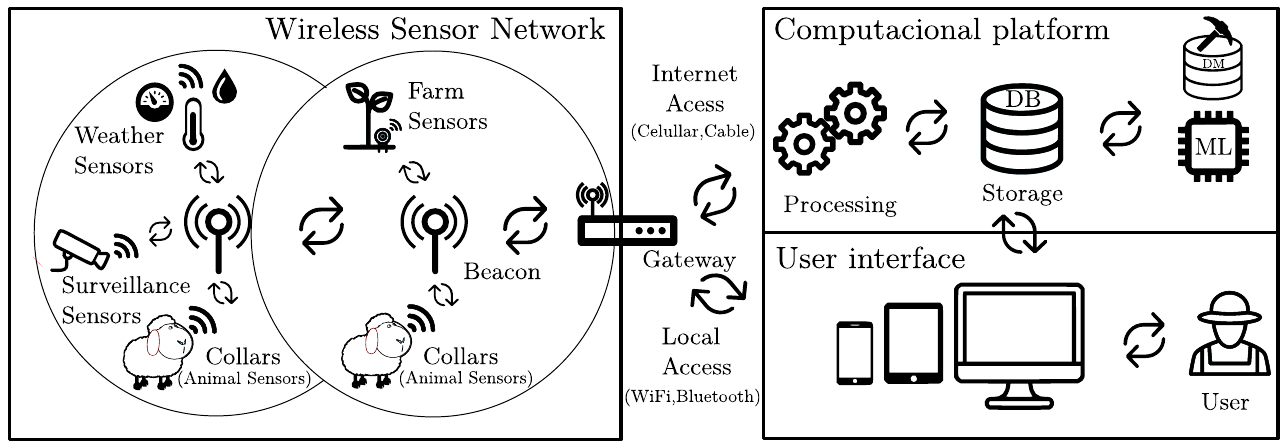
Figure 2. SheepIT overall system architecture .